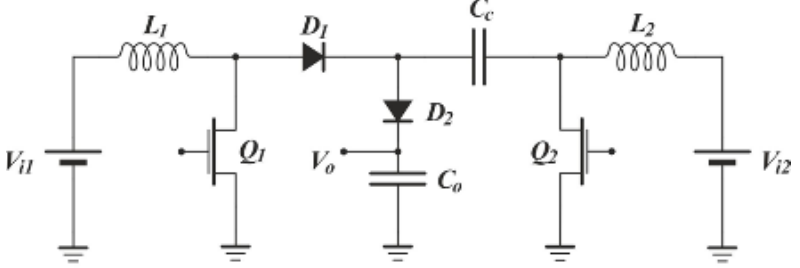
Figure 22. The MI DC-DC converter presented in [50], in the case of dual-input.